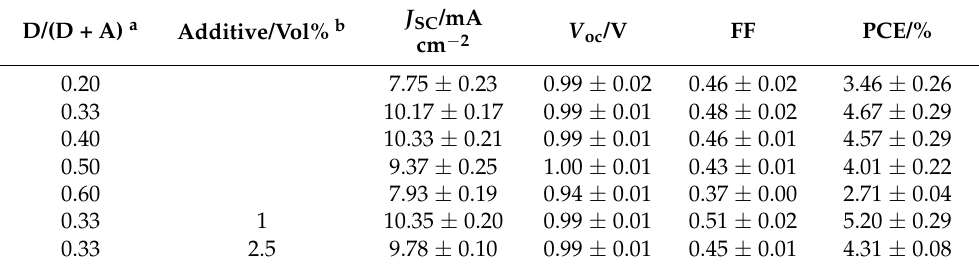
Figure 5. J - V characteristics of OSC devices composed of PTB7:EH-IDTBR. Table 1. Summarized photovoltaic performances.